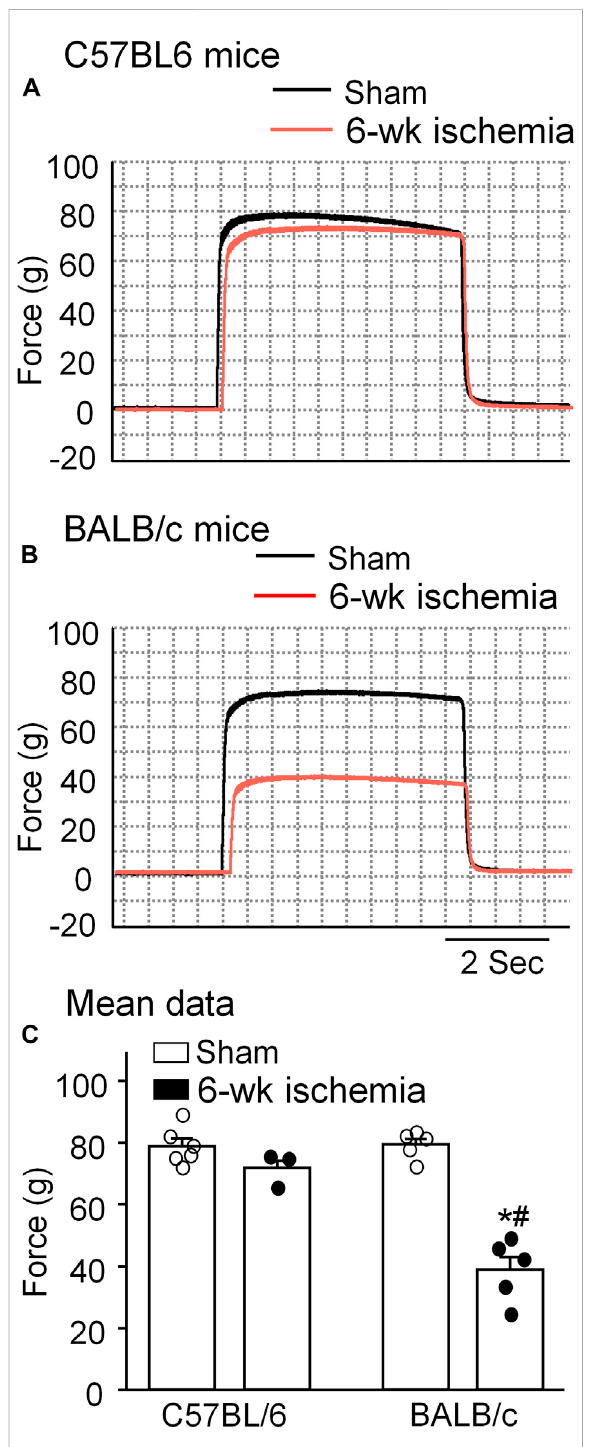
FIGURE 4 Representative (A,B) and summary (C) data for in situ sciatic nerve-stimulated gastrocnemius muscle tetanic contraction in all experimental groups. Data are mean ± SEM, n = 6, 3, 5, and 5 mice in C57BL/6 sham, C57BL/6 Isch, BALB/c sham, and BALB/c Isch group, respectively. * p < 0.05 vs. C57BL/6 sham or BALB/c sham, respectively; # p < 0.05 vs. C57BL/6